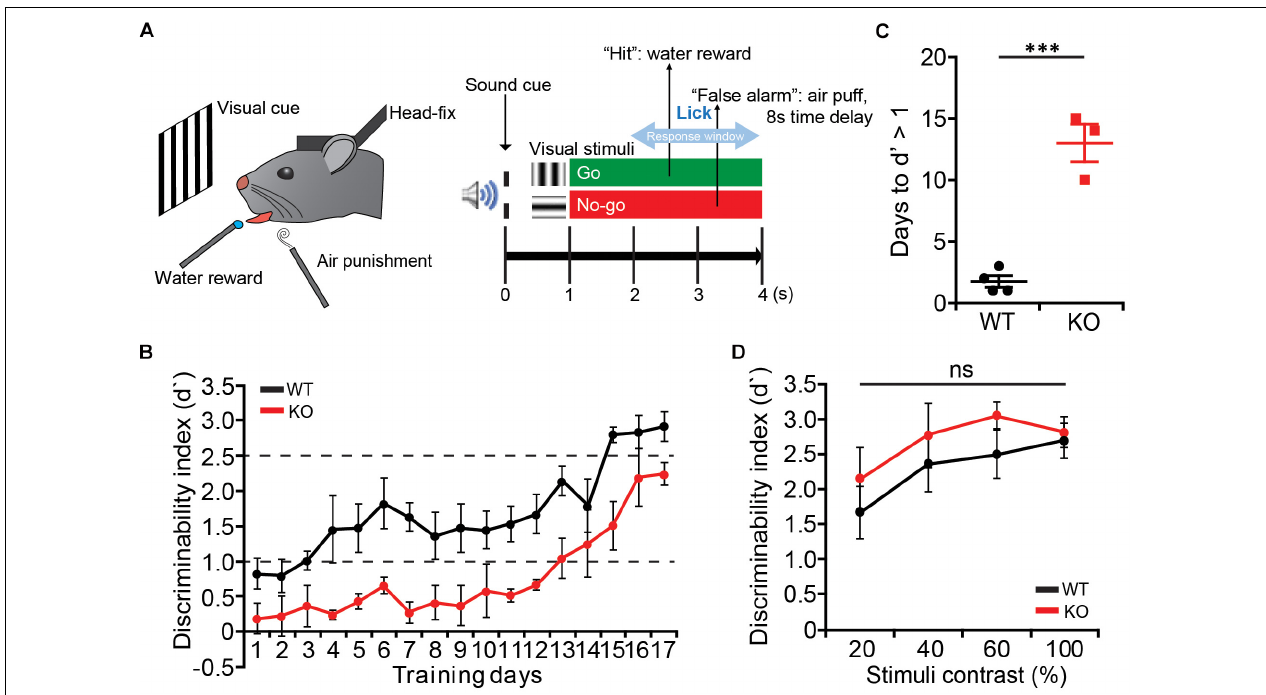
FIGURE 5 | Delayed learning of visual discrimination but normal visual attention in Lrrc4c − / − mice. (A) Schematic illustration of the visual discrimination task for head-fixed mice. (Left) Schematic of mice under the task. (Right) Task design. (B) The learning curve of WT (black) and KO mice (red). Note that Lrrc4c − / − mice show slower learning of the task. n = 4 (WT), n = 3 (KO). (C) Learning days required for mice to reach the initial learning stage (d (cid:48) = 1). n = 4 (WT), n = 3 (KO), ∗∗∗ p < 0.001, Student’s t -test. (D) Discrimination performance of mice at lower contrasts of visual stimuli. Note that the Lrrc4c − / − mice show similar levels of discrimination performance compared to the WT mice at low-contrast visual stimuli. n = 4 (WT), n = 3 (KO), ns, not significant, two-way ANOVA [ (B) t ( 5 ) = 8.048; p = 0.0005; (D) interaction, F ( 3 , 15 ) = 1.032, p = 0.4066; genotype, F ( 1 , 5 ) = 0.6932, p = 0.4430; stimulus, F ( 3 , 15 ) = 18.09, p <